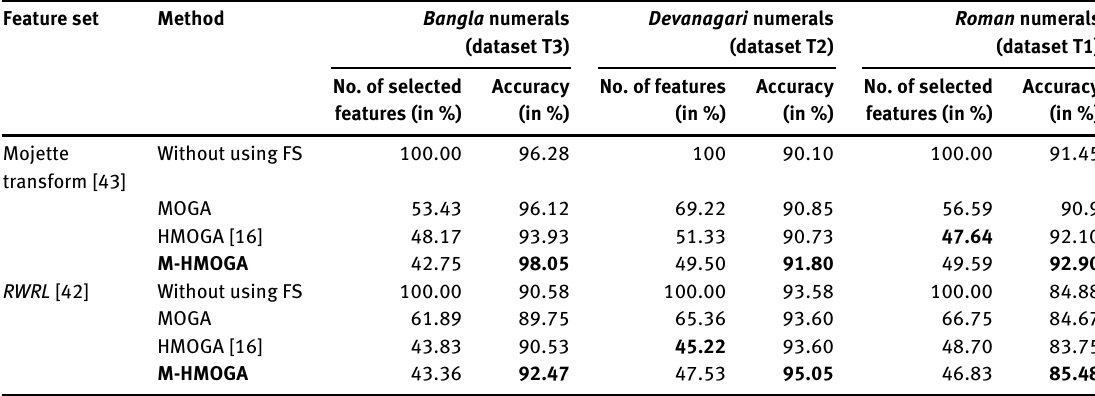
Table 10: Comparison of the Proposed FS Model Called M-HMOGA for Two Feature Sets with HMOGA and MOGA Using MLP as the Classifier in E2 (Best Results Are Made